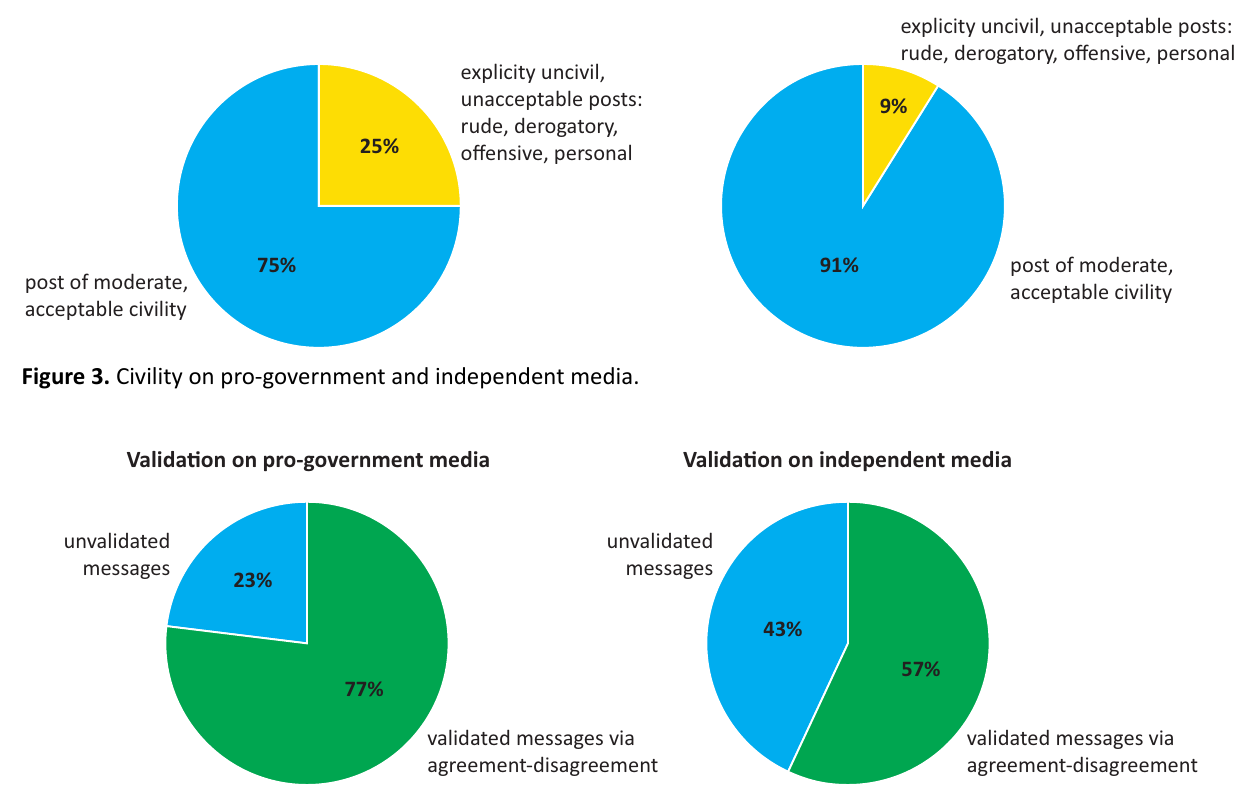
Figure 4. Validation of claims to normative rightness on pro-government and independent media. Media and Communication, 2019, Volume 7, Issue 3, Pages